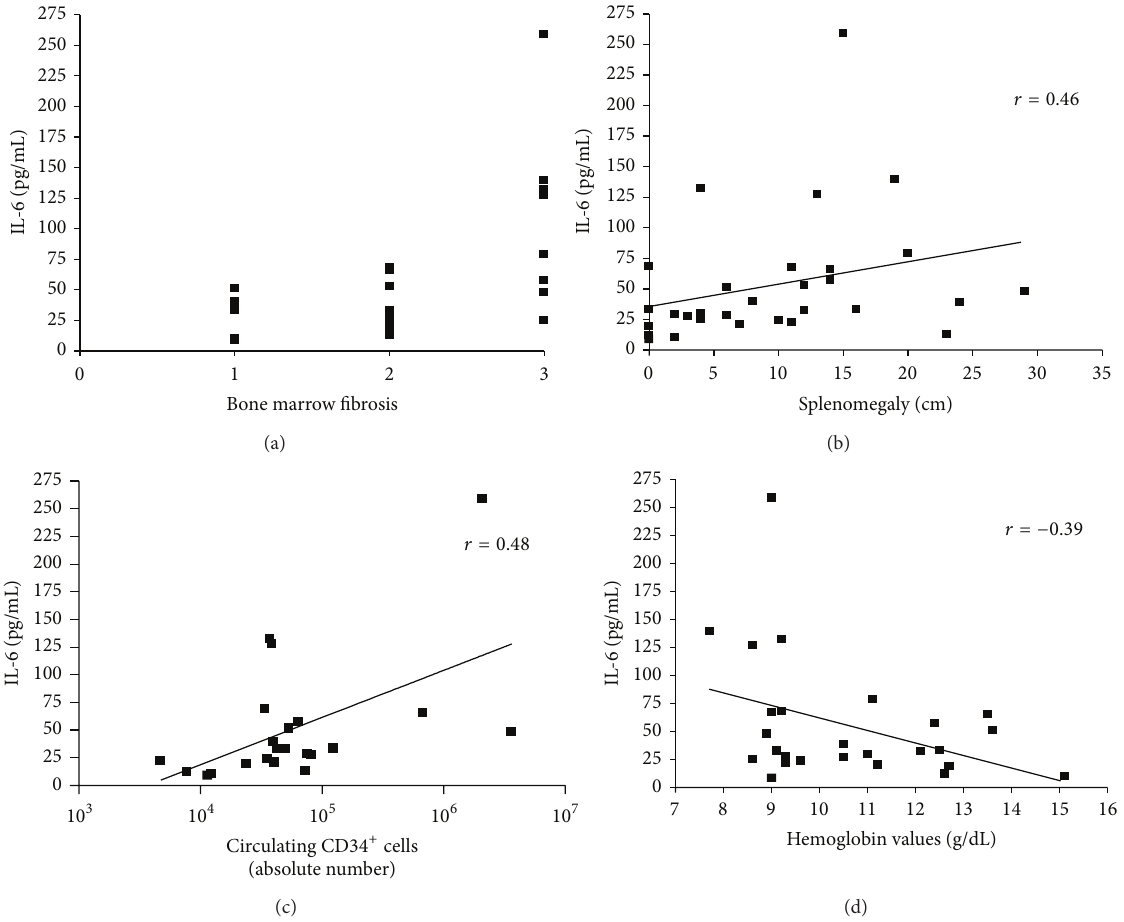
Figure 3: Correlation between IL-6 plasma levels and BM fibrosis, splenomegaly, number of circulating CD34 + cells, and hemoglobin values . Irrespective of mutational status, IL-6 plasma levels correlated with BM fibrosis ( 𝑝 = 0.0056 ; 𝑟 = 0.49 ), splenomegaly ( 𝑝 = 0.018 ; 𝑟 = 0.46 ), and the absolute number of circulating CD34 + cells ( 𝑝 = 0.029 ; 𝑟 = 0.48 ) and negatively correlated with hemoglobin values ( 𝑝 = 0.047 ; 𝑟 = −0.39 ); (a, b, c, and d, resp.). 𝑥 -axis of (a) shows BM fibrosis